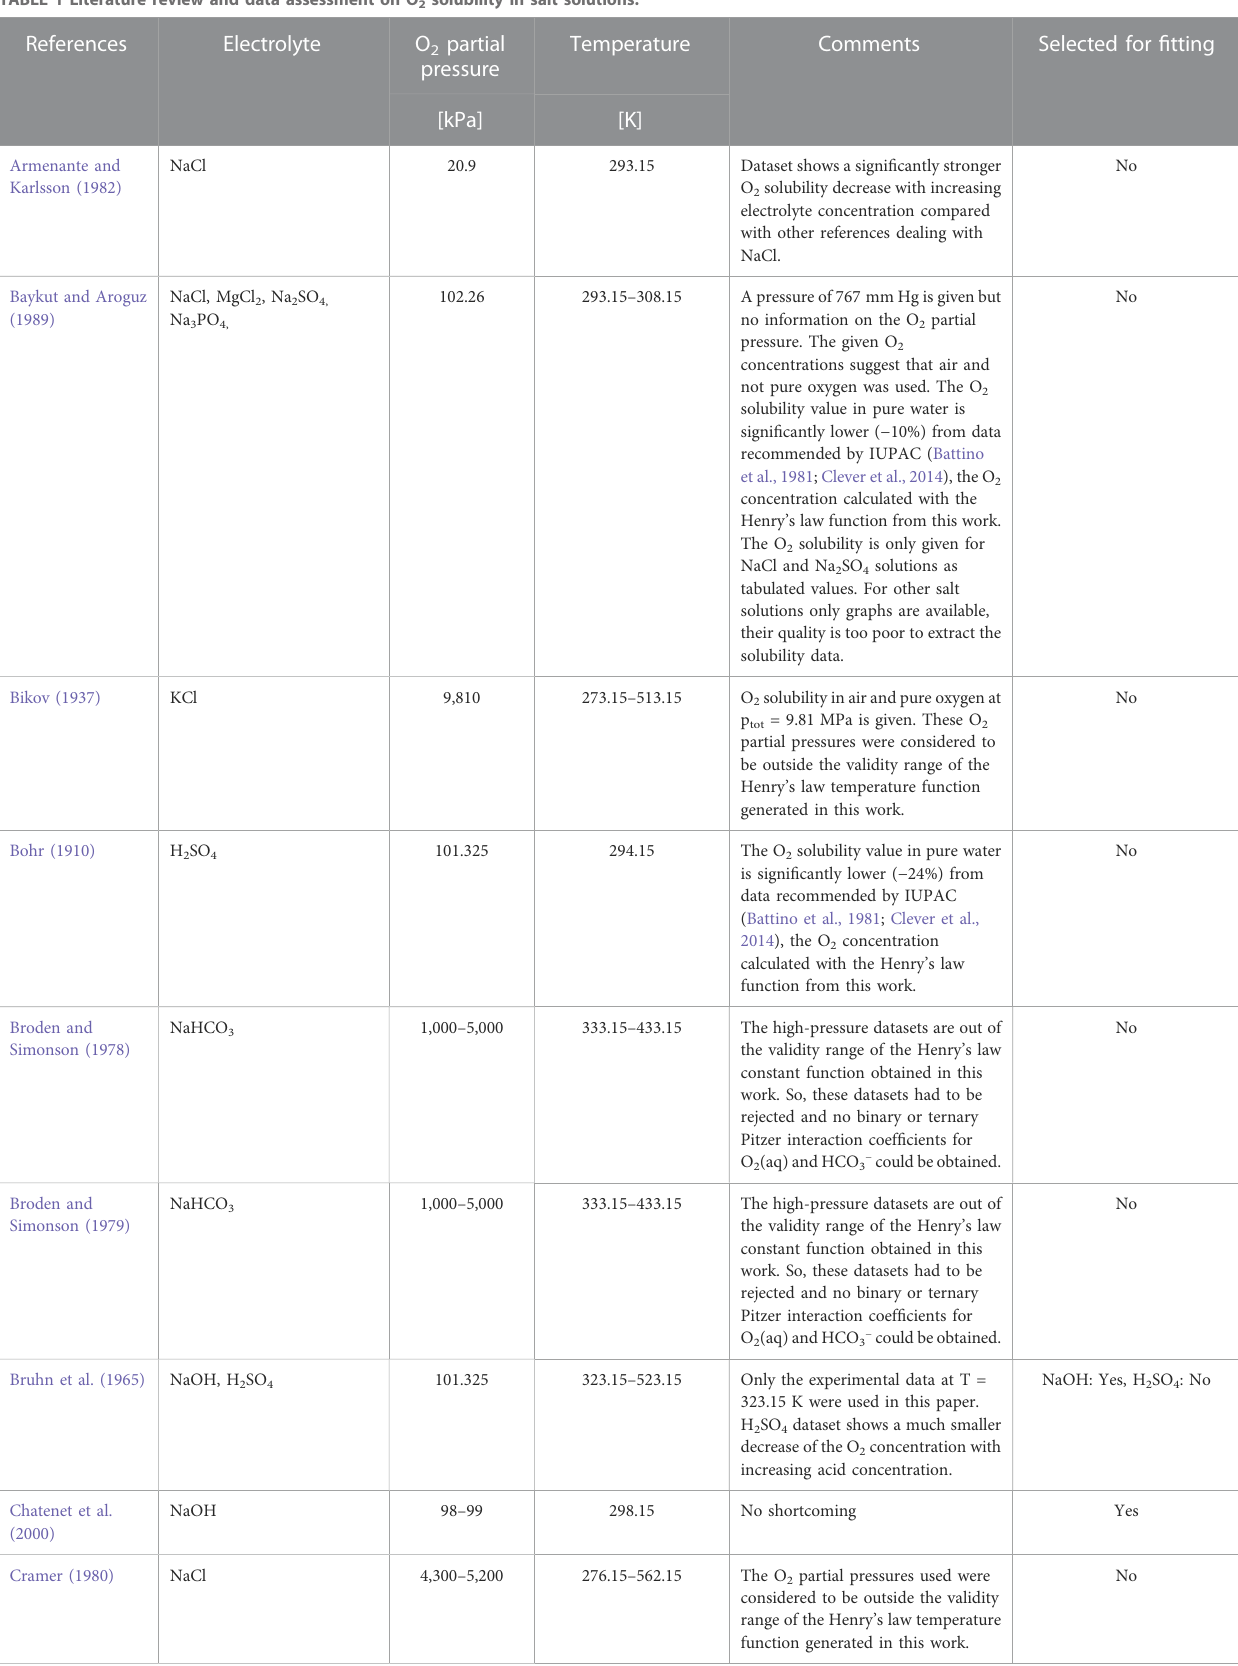
TABLE 1 Literature review and data assessment on O 2 solubility in salt